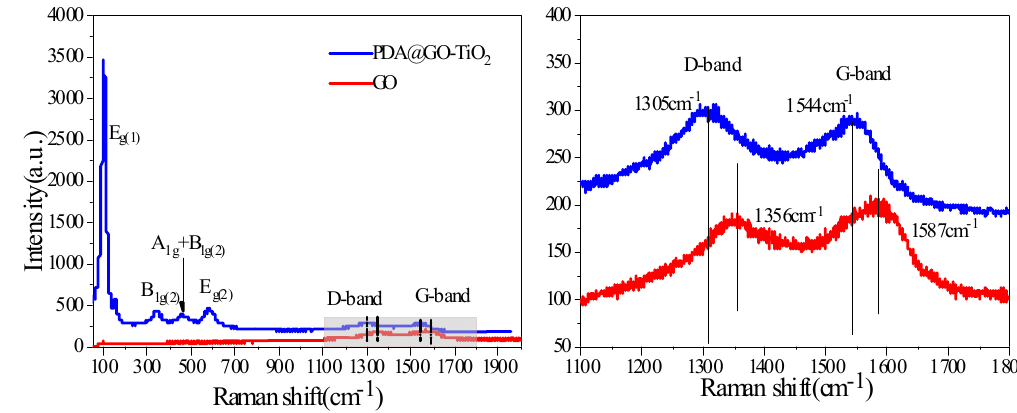
Figure 5. Raman spectra of GO and nano-PDA@GO-TiO 2 composites.